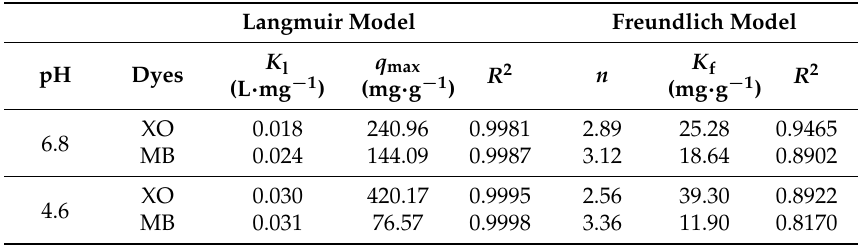
Table 2. Isotherm parameters for the adsorption of XO and MB onto PEI–TORC. Langmuir Model